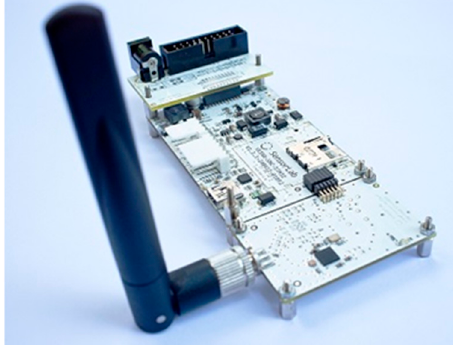
Figure 6. VESNA high-performance microcontroller.